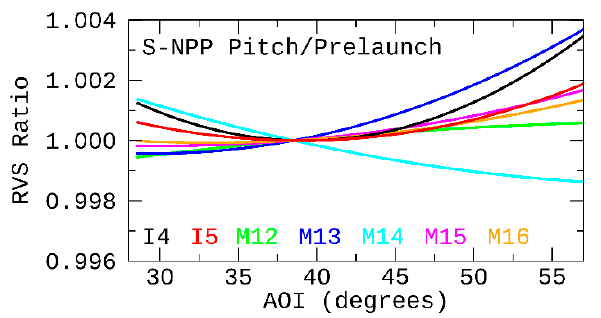
Figure 11. S-NPP VIIRS pitch-to-prelaunch RVS ratios for all TEB. Results are averaged for HAM- side A. HAM-side